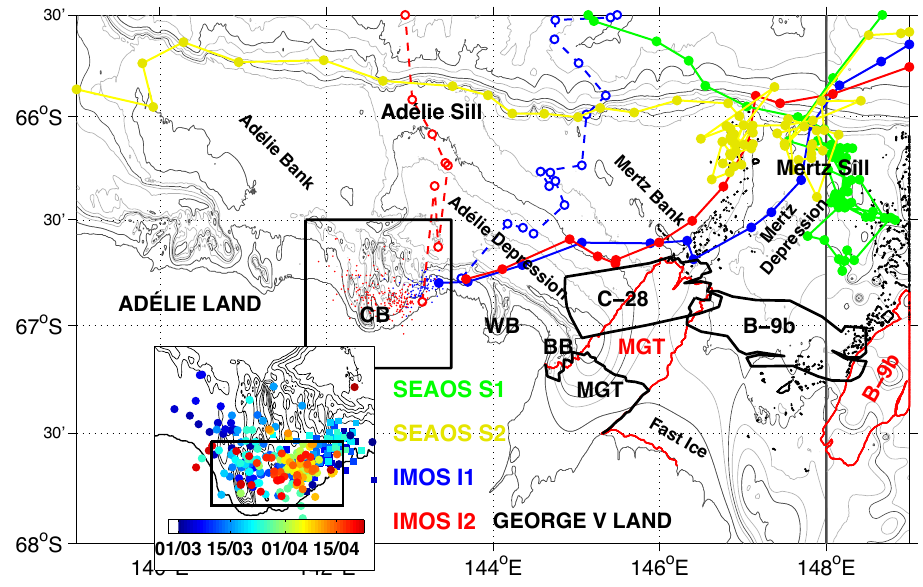
Fig. 2. The Ad´elie Depression and surrounds with 500m resolution bathymetry from Beaman (2009) between 139–148 ◦ E and ETOPO1 (2009) from 148–149 ◦ E. Major contour intervals shown for 4000, 3000, 2000, 1000, 500 and 200m. The minor contour interval is 100m and 200m north and south of the 1000-m isobath, respectively. Features include the Ad´elie Bank (AB), Ad´elie Depression (AD), the Ad´elie Sill (AS), Mertz Bank (MB), Mertz Depression (MD) and Mertz Sill (MS). Coastal embayments shown are Commonwealth Bay (CB), Watt Bay (WB) and Buchanan Bay (BB). Glacial features include the Mertz Glacier (MGT, pre-2010), iceberg B-9b and a fast ice region east of the MGT. Grounded icebergs indicated by black dots. The occupation of the Mertz Bank and Sill by SEaOS seals (S1 green-filled circles, S2 yellow-filled circles) and IMOS seals I1 and I2 (blue and red lines/circles, respectively) is shown. For the IMOS seals, filled circles/full lines indicate the pathway into the region (26–28 February) and the open circles/dashed lines indicate the exit pathway. The pre-calving position of the MGT and iceberg B9-b is shown in red. The post-calving position of iceberg C28 on the 26 February is indicated by the thick black line (digitized from a MODIS image). Inset shows timing of seal CTD profiles in the Commonwealth Bay area, the black box indicating the limit of data used for sea ice growth